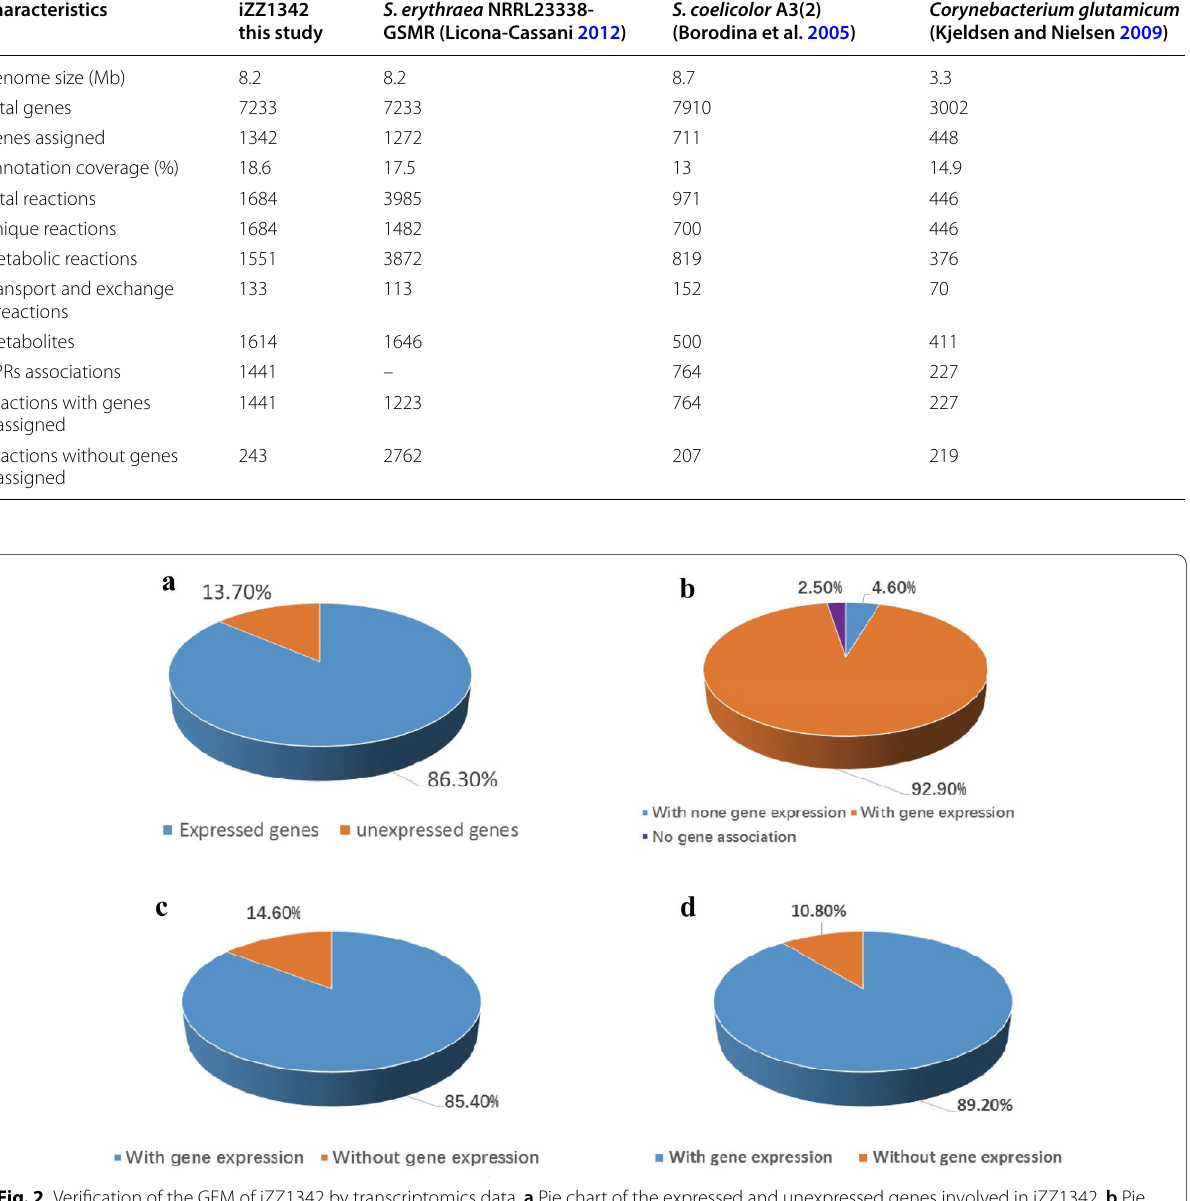
Fig. 2 Verification of the GEM of iZZ1342 by transcriptomics data. a Pie chart of the expressed and unexpressed genes involved in iZZ1342. b Pie chart of the verified reactions and other reactions in total 1441 reactions (except the exchange and transport reactions). c Pie chart of the verified single-gene reactions and other reactions in total single-gene reactions. d Pie chart of the verified multi-gene reactions and other reactions in total multi-gene